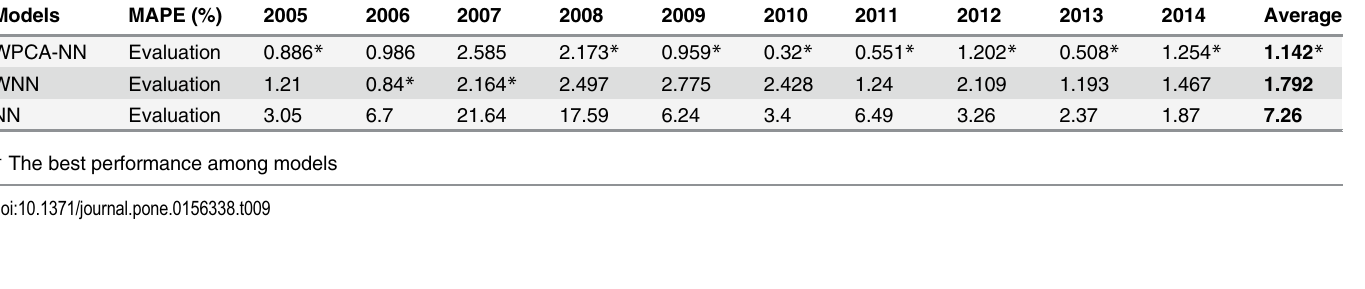
Table 9. Performance of the models, MAPE ratio of evaluation results for SiMSCI futures. Models MAPE (%) WPCA-NN Evaluation WNN